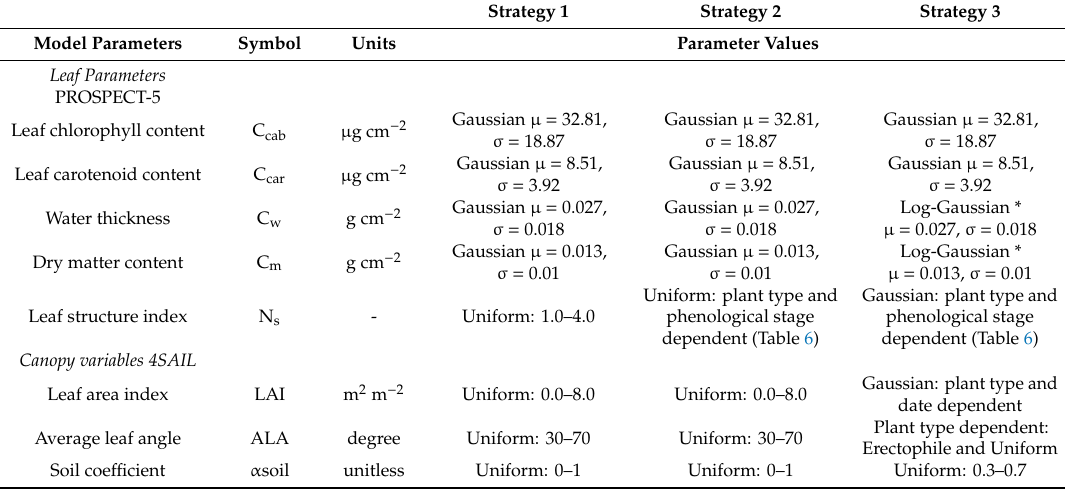
Table 4. Parameterization of the PRO4SAIL radiative transfer model. The distributions used during LUT generation for each parameter are listed along with fixed values. The asterisk indicates that water thickness and dry matter content log-gaussian distributions in Strategy 3 were generated using a covariance matrix to simulate the correlation between water thickness and dry matter content. The covariances are presented in Table 5.